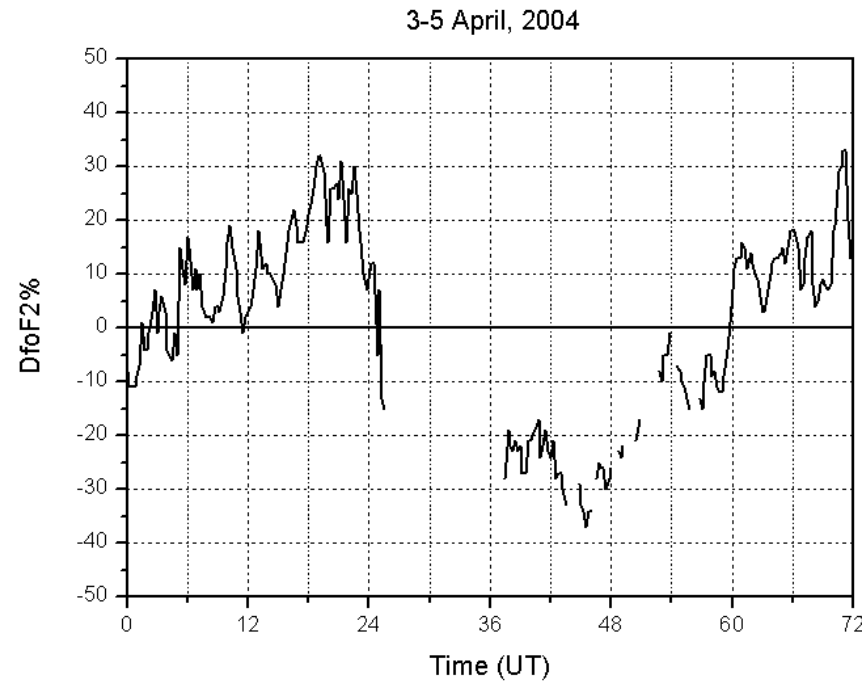
Fig. 7. Relative deviations, D fo F2%, of fo F2 from the corresponding monthly median value during 3–5 April